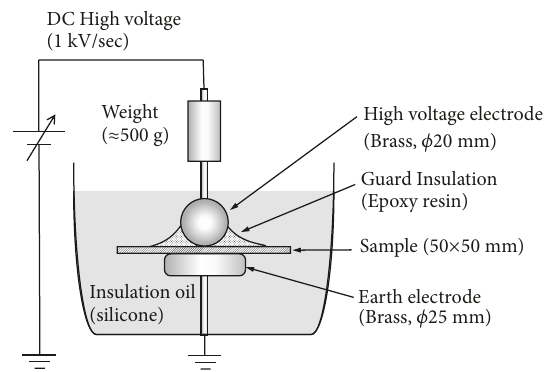
Figure 2: Experimental system for measuring dielectric breakdown strength.